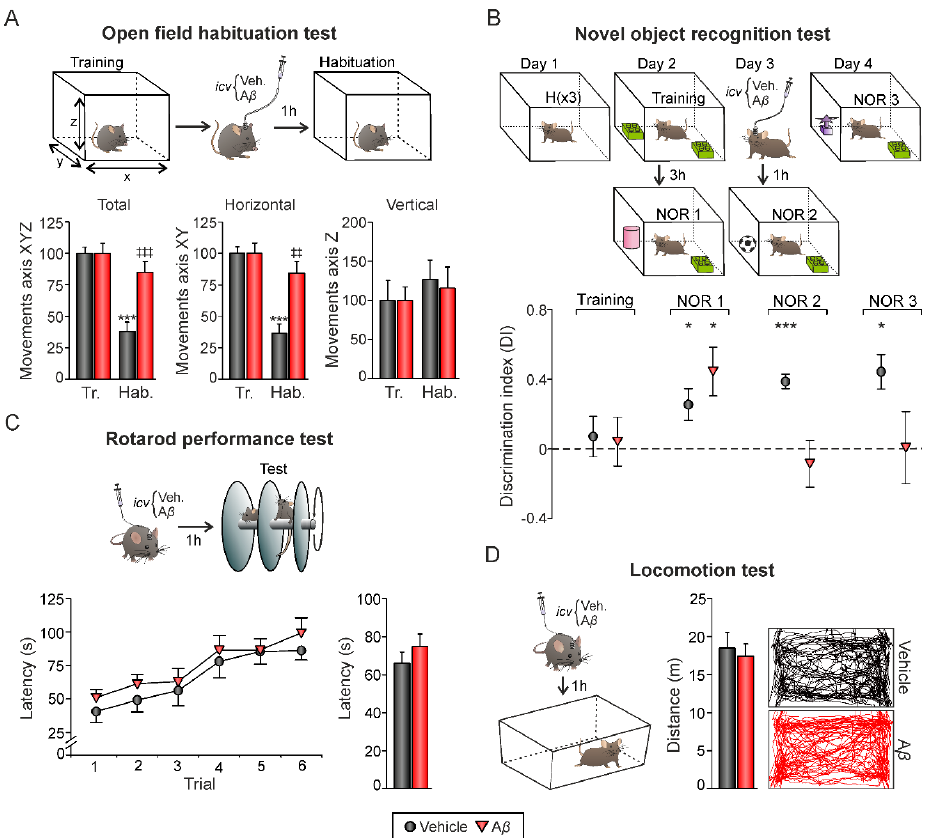
Figure 4. Hippocampal-dependent memory tasks. ( A ) On top, open field habituation test. Mice underwent a training session by being exposed to an open field. 24 h later, and 1 h after icv. administration, animals were re-exposed to the open field (habituation session). On each session, mice freely explored the environment for 15 min. Movements in the X, Y, and Z axis were detected with an infrared system. Below, total activity (movements in the XYZ axis), horizontal activity (XY axis), and vertical activity (Z axis) during training and habituation sessions (mean ± SEM) are represented. *** p < 0.001. Asterisks indicate differences between training and habituation sessions within each experimental group. ‡‡ p < 0.01, ‡‡‡ p < 0.001. Crosses reflect differences between A β and vehicle (control animals) in habituation. Note that exploratory activity decreases in the vehicle group during the habituation session compared to the training session, but also compared to the A β group during the habituation session. ( B ) On top, novel object recognition task. Three 5-min habituation trials were performed on Day 1. On Day 2, a 10 min training session with two identical objects occurred. A test session (NOR1) was performed 3 h later for evaluation of short-term memory, substituting one familiar object for a novel one. On days 3 and 4, NOR2 and NOR3 trials were performed to evaluate long-term memory. Icv. injections took place one hour before NOR2 trial. Below, discrimination index (defined as the difference in exploration time between the two objects divided by the total time spent exploring both objects) for each experimental group during trials. After icv. injections, only vehicle-injected mice showed positive discrimination toward the novel object. * p < 0.05, *** p < 0.001. Tr., training; Hab., habituation. ( C ) On top, Rotarod performance test. 1 h after icv. injections, animals performed a single session consisting of six trials. Mean latency to fall o ff the rod was calculated for each trial (bottom left graph) and the whole session (bottom bar plot). ( D ) Locomotion test. 1 h after icv. administration, mice freely explored an empty chamber for 15 min. Mean travelled distance was recorded by a LABORAS ® system. Right, representative movement tracking of animals from both experimental groups. No di ff erences were found between treatments in C or